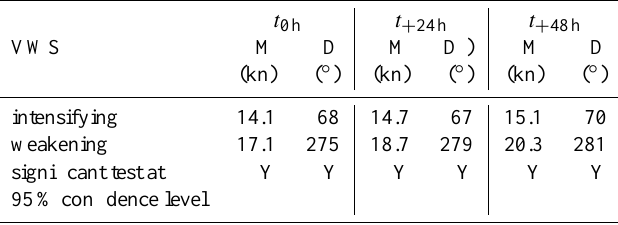
Table 1. The average environmental vertical wind shear between 200 and 850hPa for the intensifying and weakening cases at different times. t 0h t + 24h t + 48h VWS